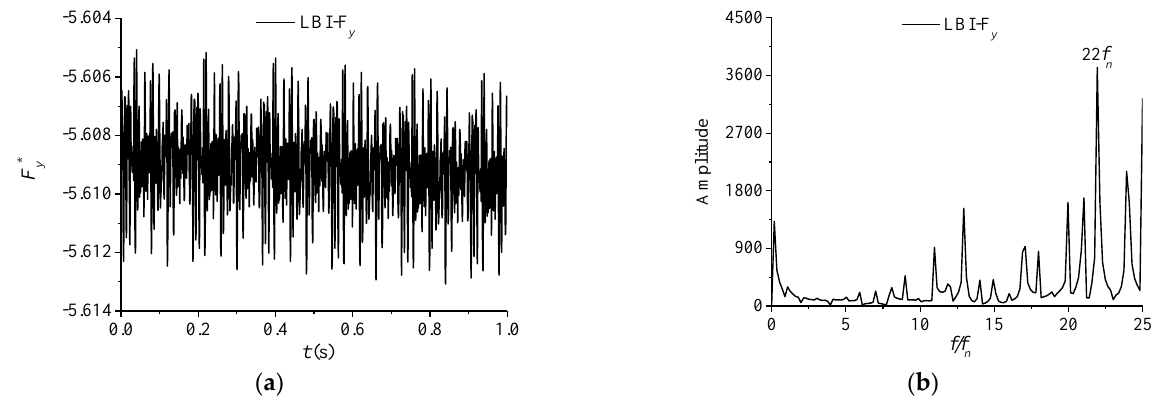
Figure 14. The axial water thrust of the runner upper crown.